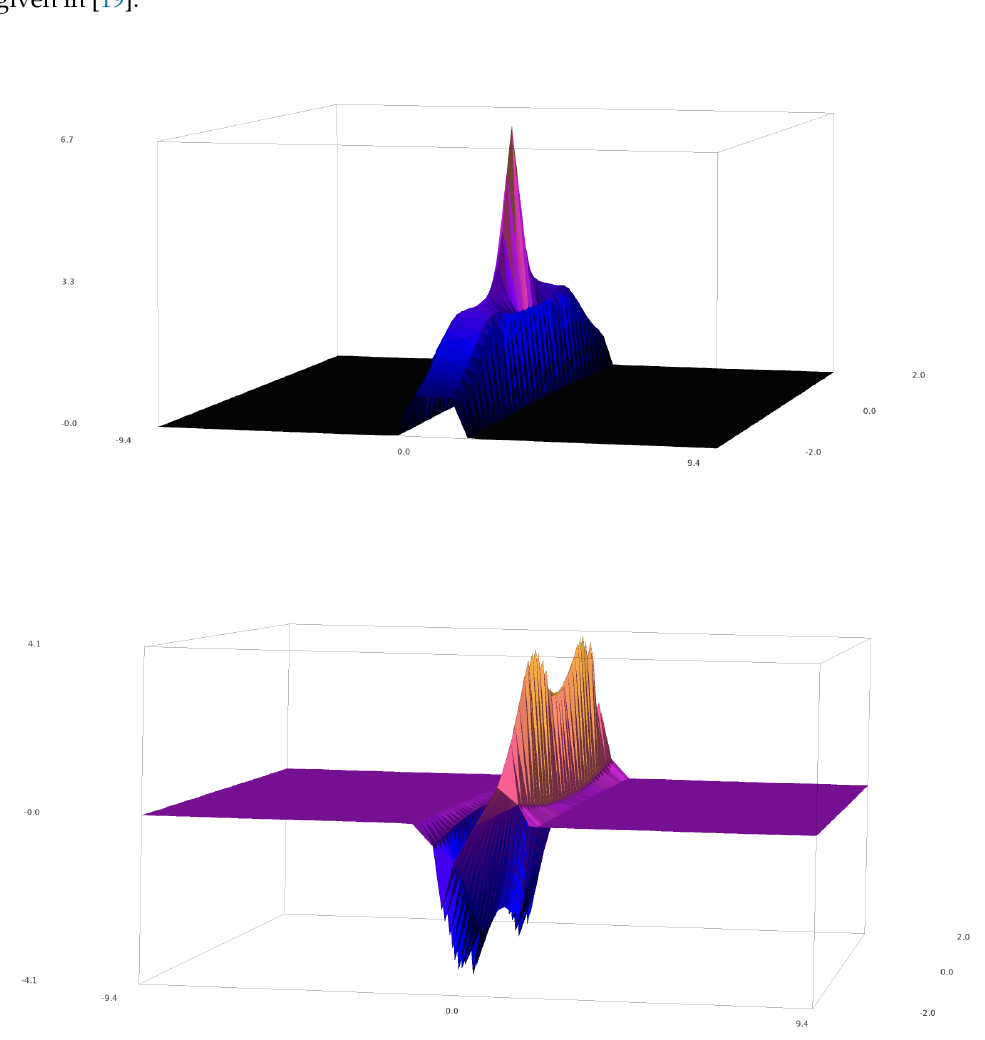
Figure 3. The plot of ψ 2 , the second-order solution to the standard NLSE [19]. Real and imaginary parts shown respectively above and below. Plotted with SageMATH